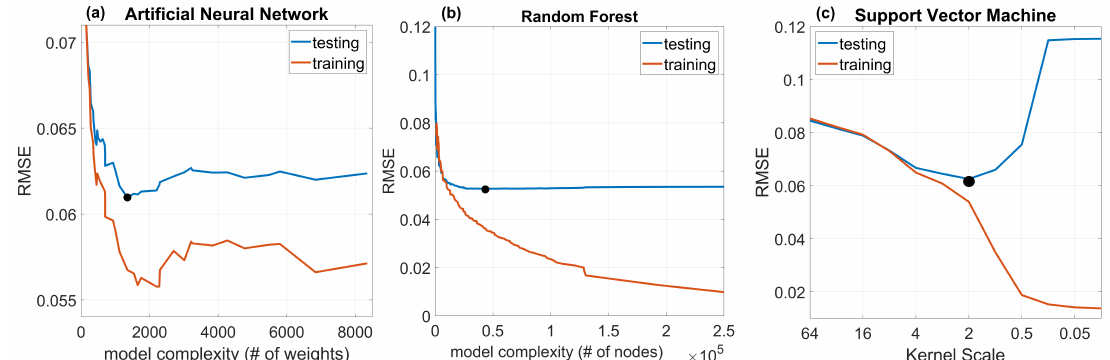
Figure 3. Root-mean-square-error (RMSE) of the training and testing data as a function of the model complexity for three different ML algorithms: ( a ) Artificial Neural Network (ANN), ( b ) Random Forest (RF), and ( c ) Support Vector Machine